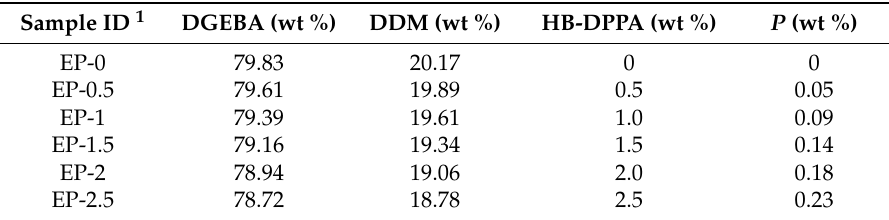
Table 6. Stoichiometric formulation of the epoxy system.